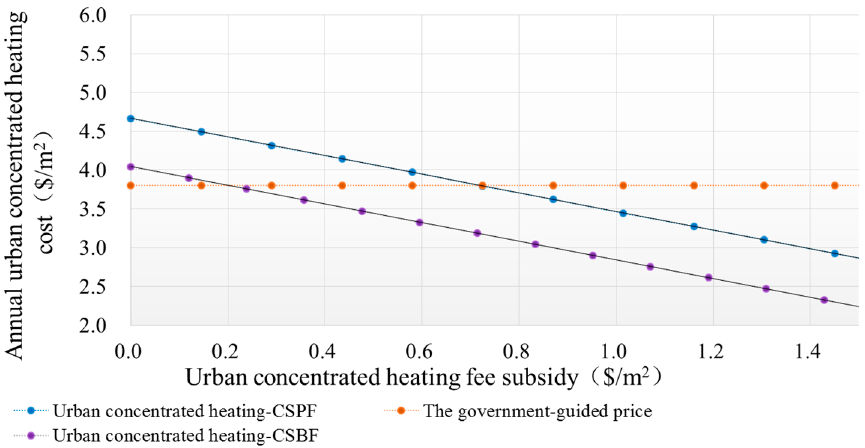
Figure 8. Influence of urban concentrated heating subsidy on economic performance of a CSDF-DHS.